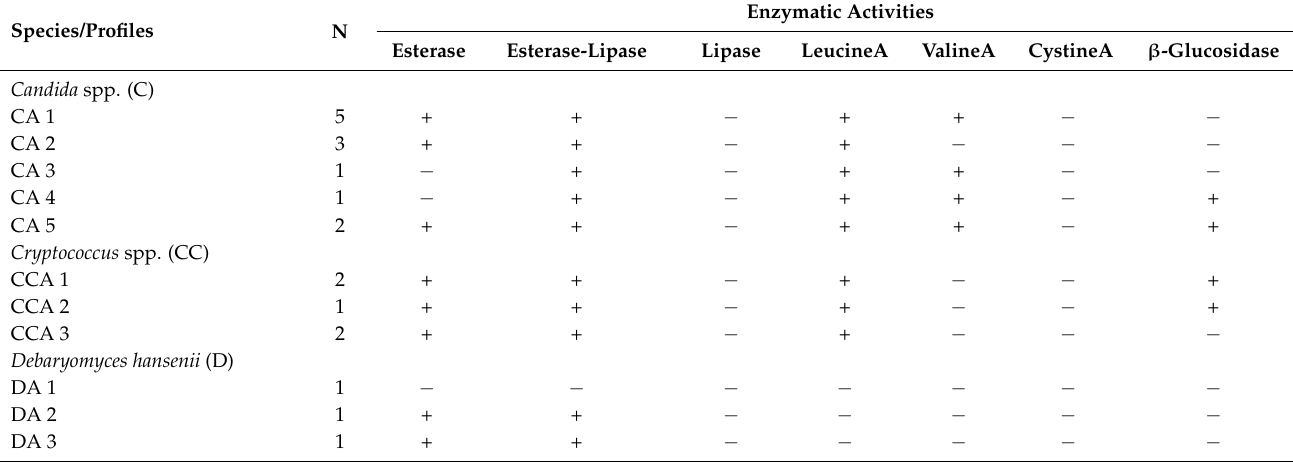
Table 1. Specific enzymatic profiles related to wine